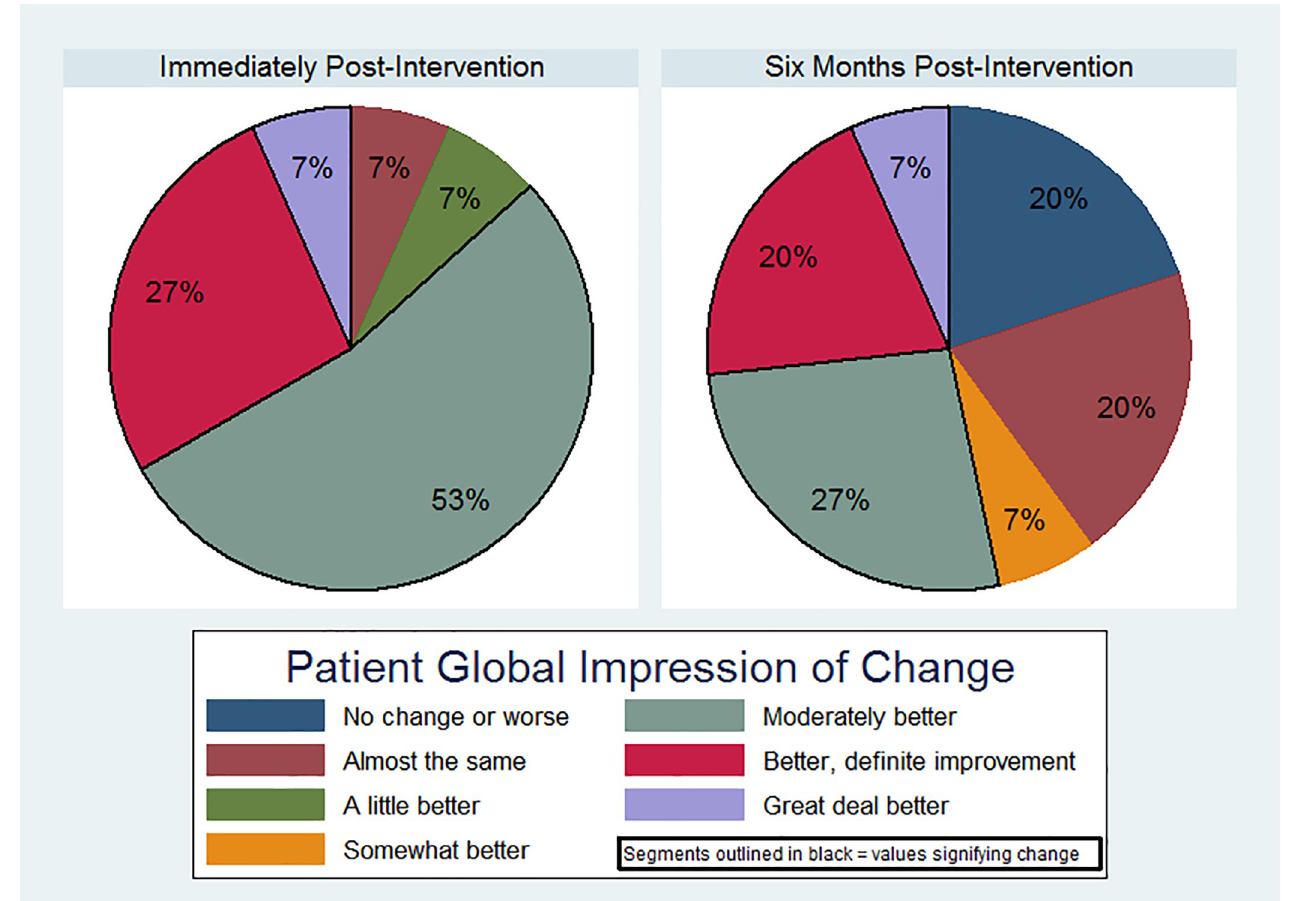
Fig 2. Global impression of change. Participants’ global impression of change immediately post-participation and six months post-participation.